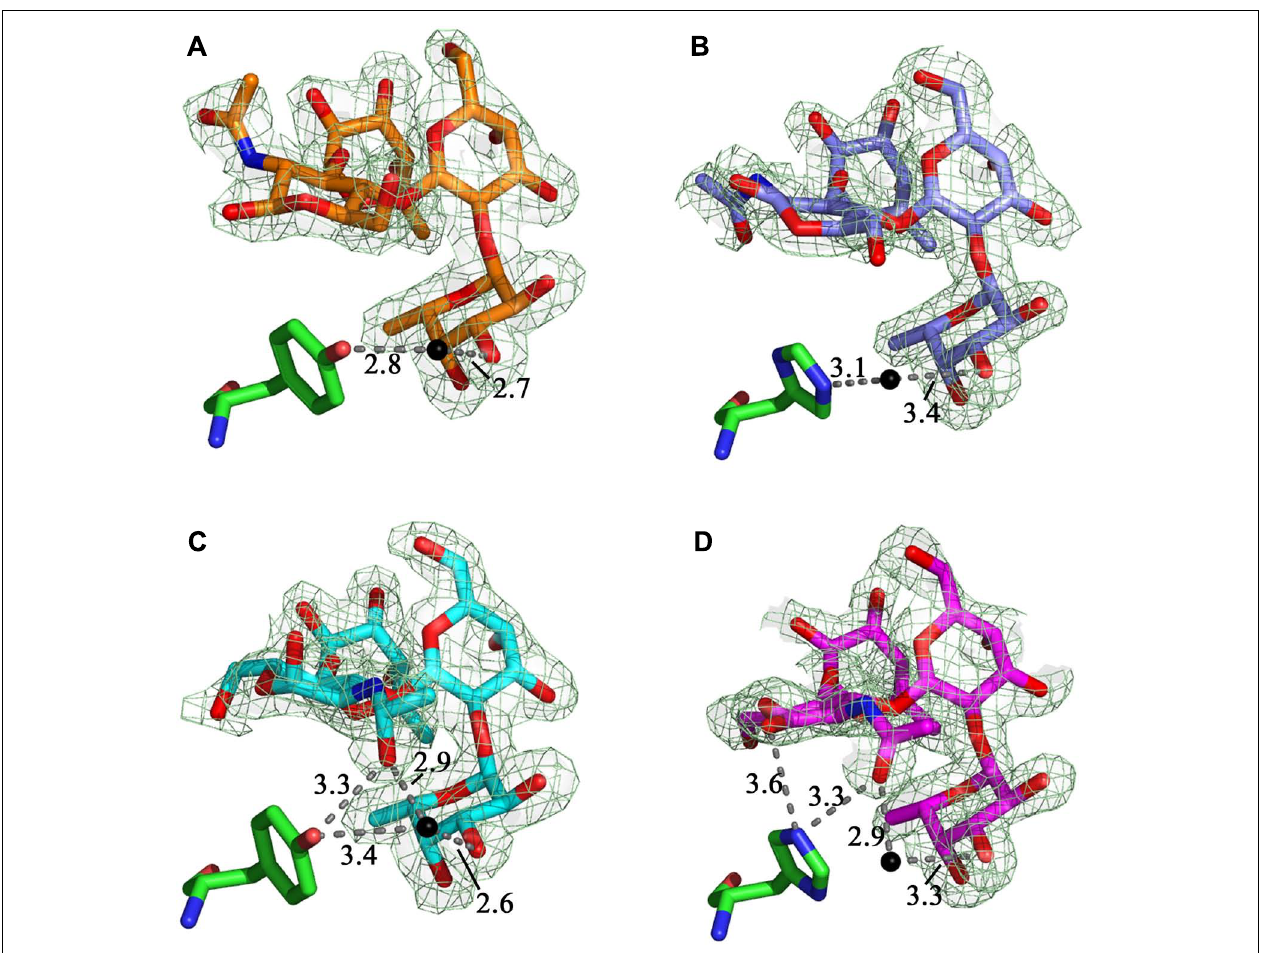
group ofTyr62 seen in the LLY lec wt-Le b complex (cyan carbons, greenTyr62) ( C ) was lost in the LLY lec wt-Le b structure (magenta carbons, greenTyr62) ( D ) as this residue was replaced by His62. Hydrogen bonds are shown in gray and water molecules as black spheres.The fit of the ligands to the relevant 2 F o – F c electron density map (dark green hash), contoured at 1 σ , are shown.